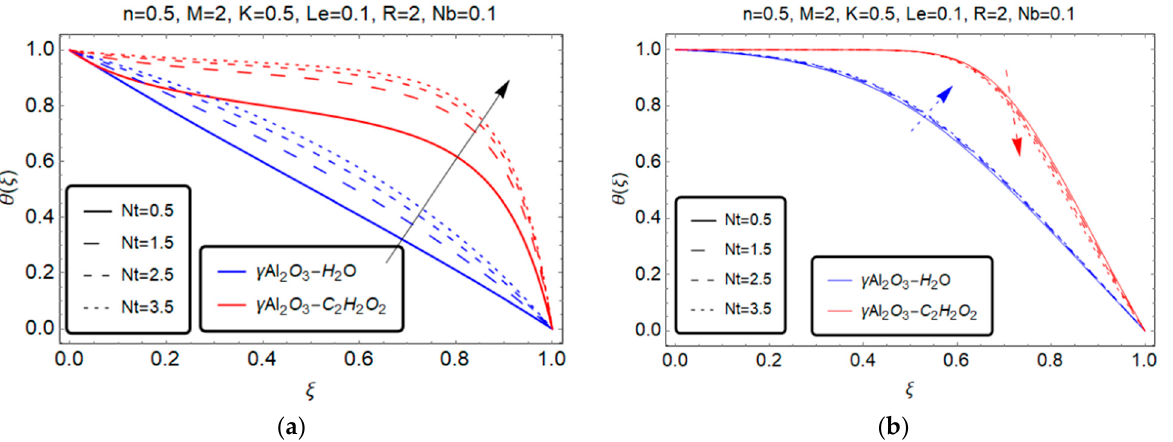
Figure 7. Effect of thermophoresis parameter N t on θ ( ξ ) . ( a ) S > 0; ( b ) S < 0.